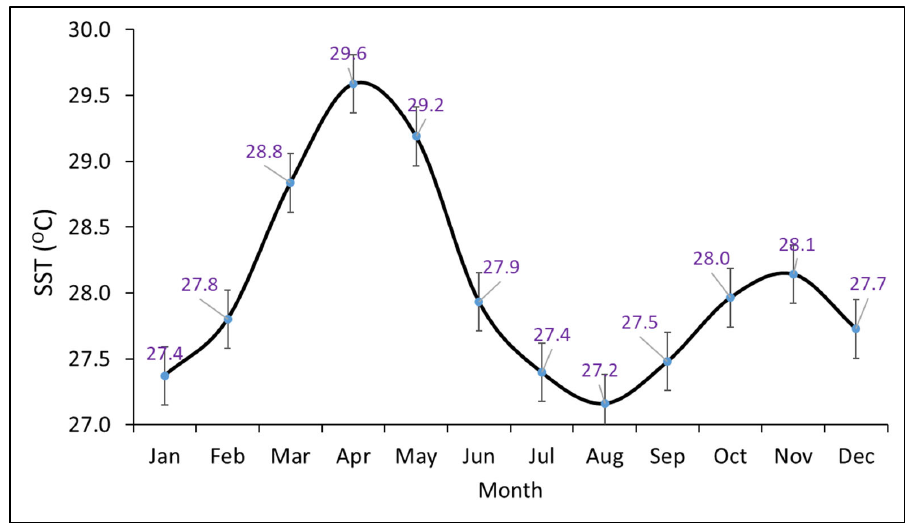
Figure 2. Average monthly SST variation in the study area from 1870 to 2018. Black straight lines indicate the standard error.